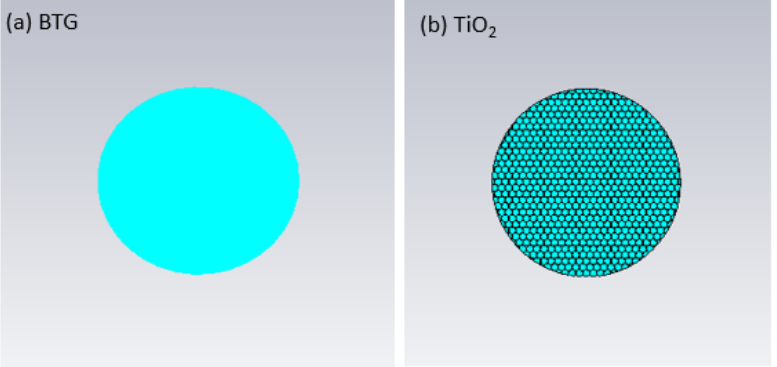
Figure 1. Schematic of BTG and TiO 2 microsphere models. ( a ) BTG microsphere with n = 1.92, and ( b ) meta-TiO 2 : TiO 2 metamaterial microsphere, made from densely packed 20-nm, n = 2.50, TiO 2 nanoparticles, having the same effective refractive index of 1.92, as BTG particle.